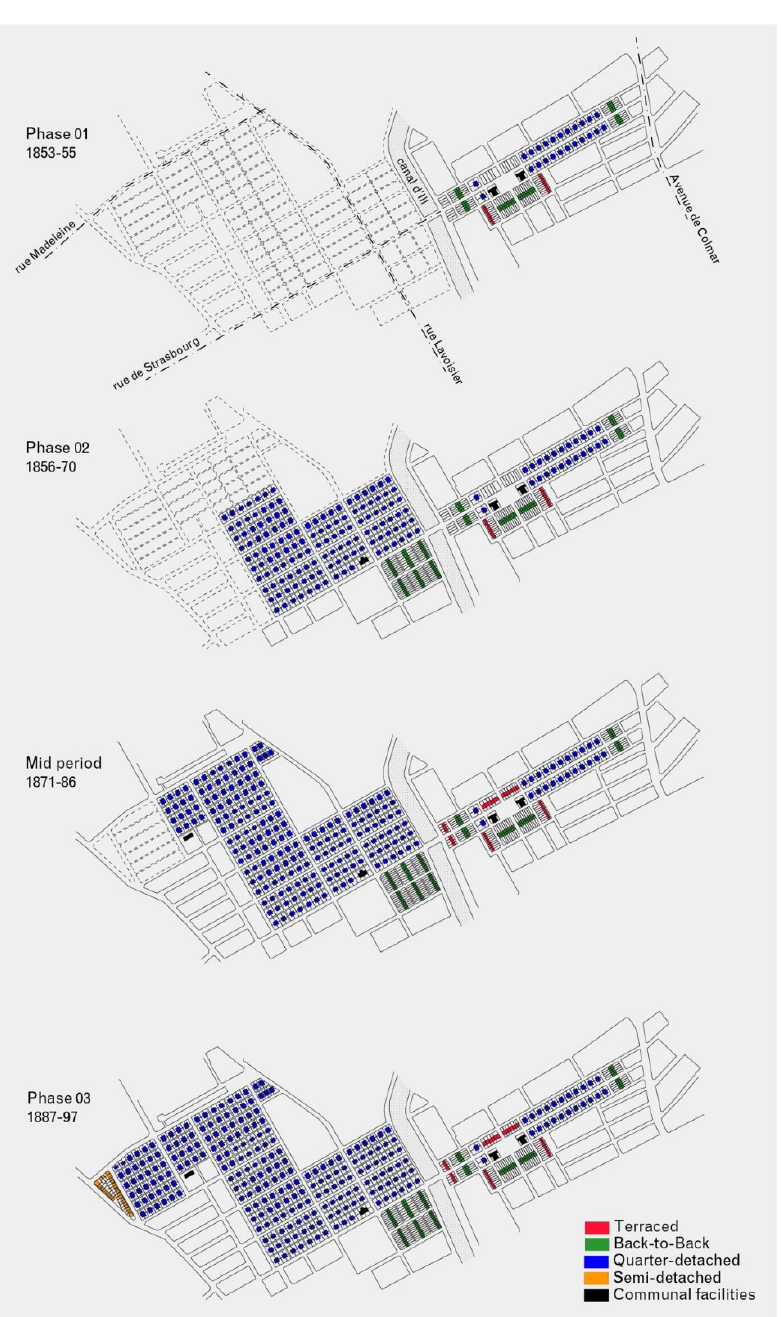
Figure 6. Construction phases of Cité Ouvrière and standardisation of housing typologies. Source: Kostourou (2020, p.